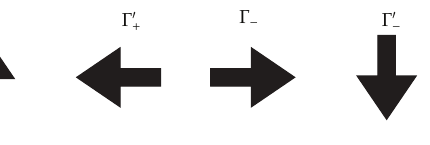
Figure 9: Assignment of arrows.